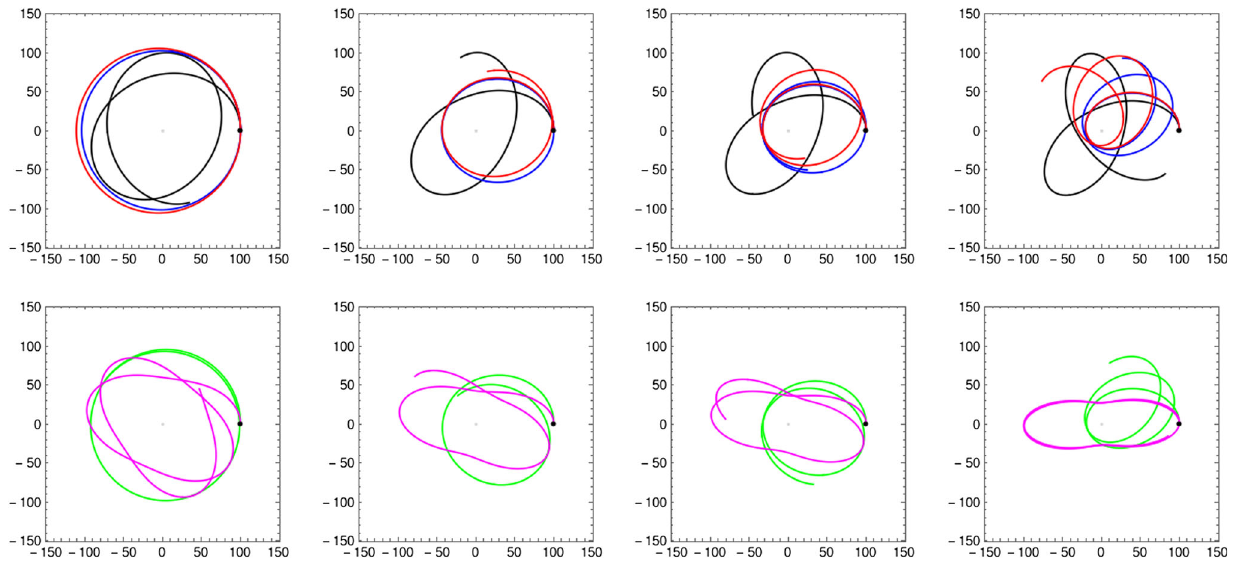
Fig. 5 Bounded trajectories for various combinations of a and q. The first row is dedicated to a ≤ 0 and the second one to a > 0. The colors refers to the values of a following the same code as the Fig. 5. From